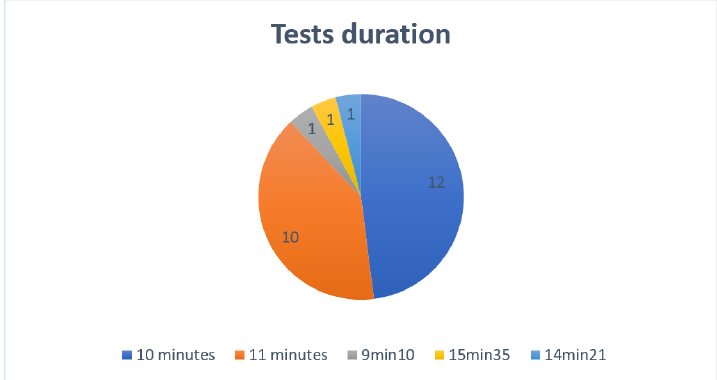
Figure 7. Average test duration: 10–11 min.